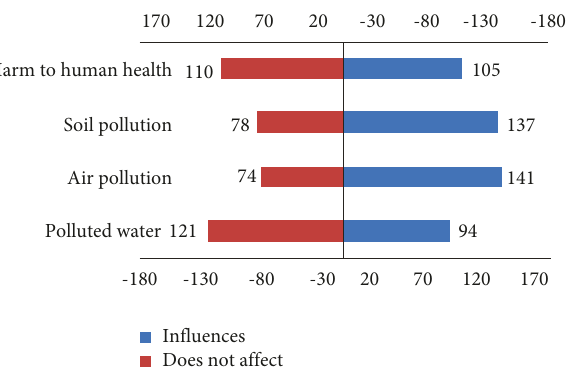
Figure 9: The distribution map of respondents’ perception of the impact of